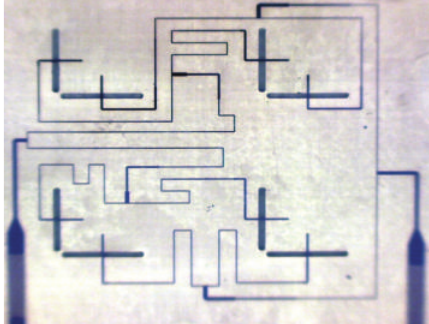
Figure 8: Prototype of a polarization agile antenna filled with liquid crystal mixture